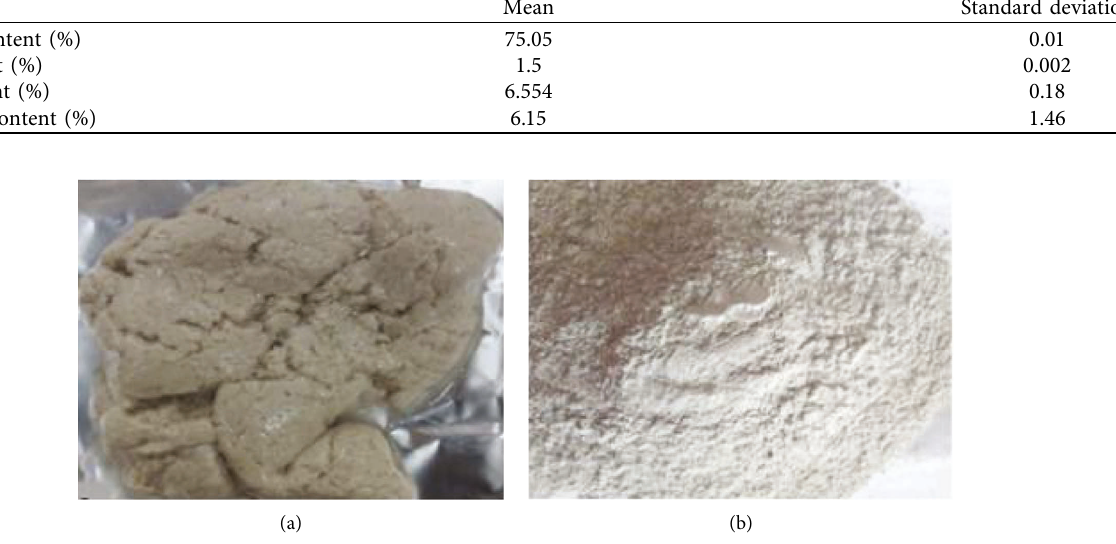
Figure 2: (a) Precipitated protein and (b) powder keratin after freeze-drying and grinding. Table 3: Dissolution and purity of extractive keratin at different conditions.